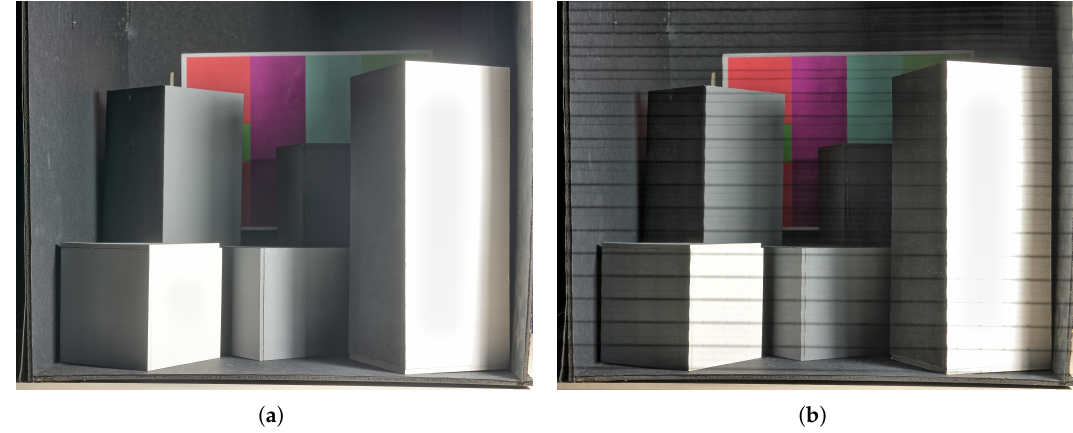
Figure 8. Comparison between two HDR captures, tone mapped for display purpose. ( a ) the veiling glare causes a loss of contrast, mostly in the darker regions; ( b ) reconstructed image as result of the method presented in this paper, described in Section